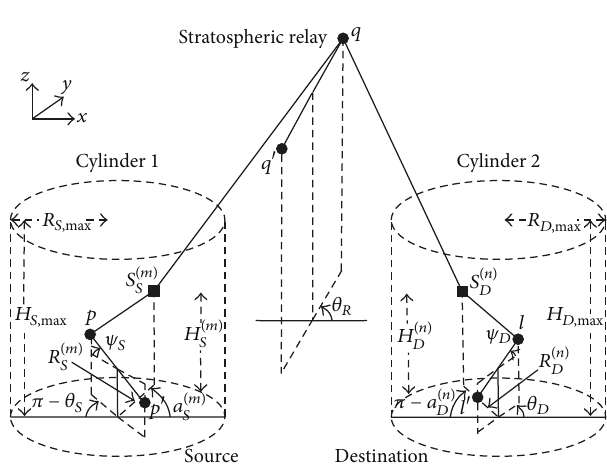
Figure 3: NLoS paths of the 3D model for a 2×2×2 MIMO MMSR